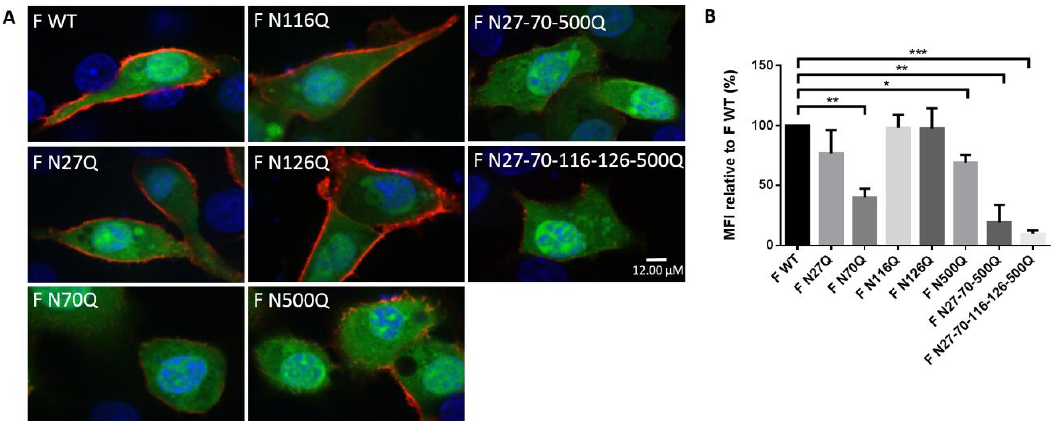
Figure 2. Surface expression analysis of RSV F glycosylation mutants. ( A ) Immunofluorescence staining of cell surface expression of glycomutant RSV F proteins. BSR T7/5 cells were transfected with a pCAXL plasmid encoding RSV F glycosylation mutants and a GFP-expressing plasmid (EGFP-N3) (green). Twenty-four h after transfection, cells were fixed and surface-expressed RSV F proteins were visualized by polyclonal goat anti-RSV antibodies and secondary donkey anti-goat IgG (AF555) (red). The nuclei were stained with DAPI (blue). Images were acquired by confocal fluorescence microscopy, scale bar = 12 µ M ( B ) Flow cytometric analysis of BSR T7/5 cells expression glycosylation mutants of the RSV F protein. BSR T7/5 cells were transfected with a pCAXL plasmid encoding WT or one of the glycosylation mutants of the RSV F protein and a GFP-expressing plasmid (EGFP-N3). Twenty-four h after transfection, the cells were detached and stained with human RSV antiserum at 4 °C to assure surface staining only. Secondary anti-human IgG conjugated with AF647 was used to detect RSV F proteins. Fluorescence intensities of fluorescence channel (FL) 4 were measured of 5000 cells expressing GFP (FL1). Surface expression is expressed as the MFI relative to F WT expression. Data represents the means (±SD) from 3 independent repeats. * p < 0.05; ** p < 0.01; *** p < 0.001 (Student’s unpaired two-tailed t test).